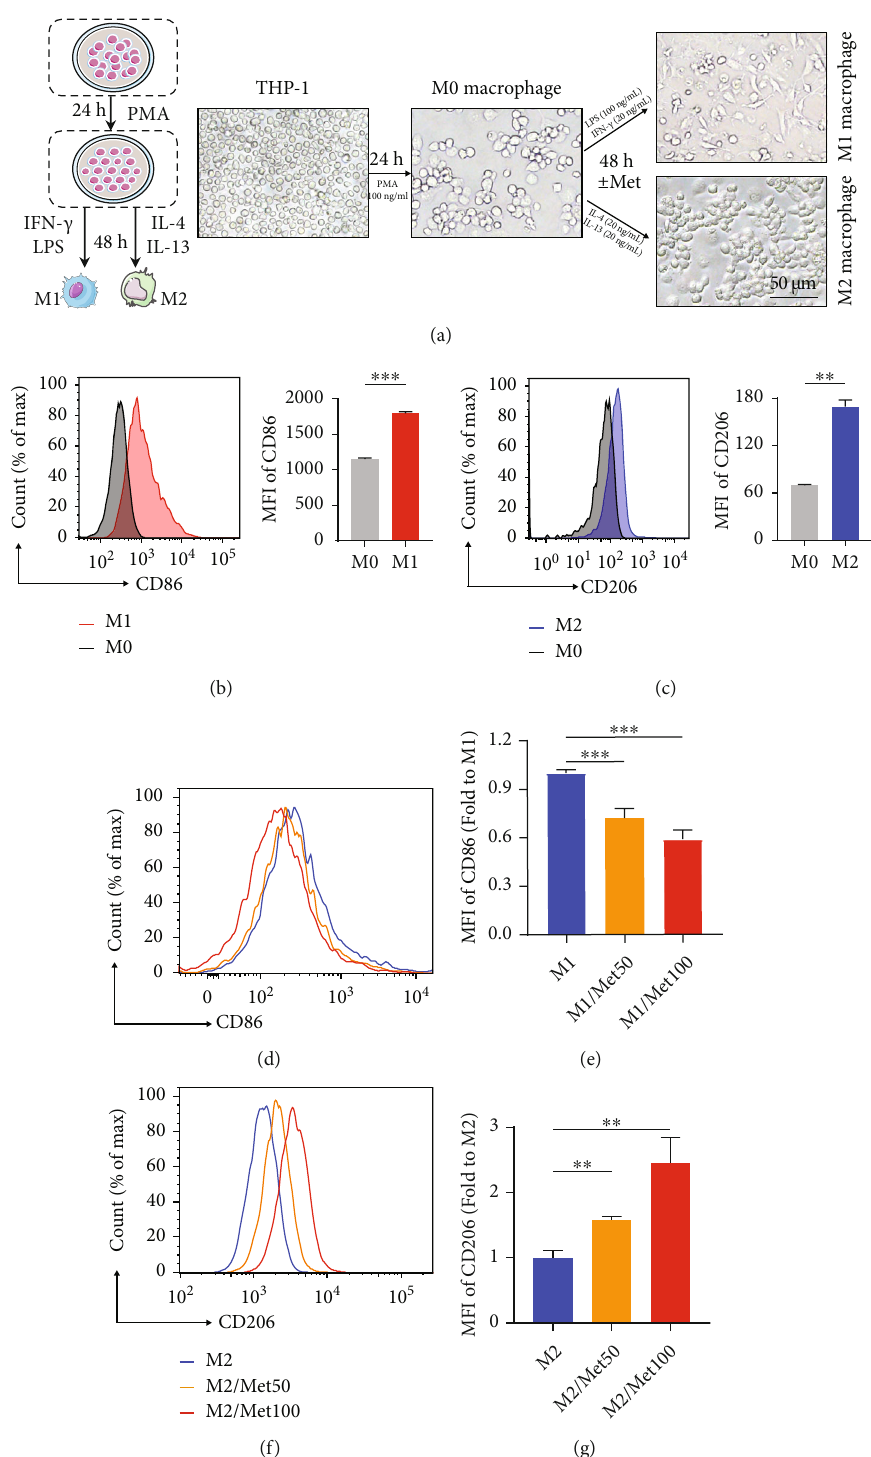
Figure 4: Metformin regulated macrophage polarization towards M2 phenotype. (a) Schematic diagram of polarization of macrophages from THP-1 to M1/M2 populations. (b, c) Representative graphs and statistical histograms of MFI of CD86 maker in M1-induced group and CD206 in M2-induced group versus M0 populations. (d) Flow cytometry plot of CD86 (M1 maker) with di ff erent doses of metformin. (e) Quantitative analysis of the MFI of CD86. (f) Representative image of CD206 (M2 maker) with di ff erent doses of metformin. (g) Quantitative analysis of the MFIofCD206.Datarepresentedas mean ± SD fromthreeindependentexperiments. ∗∗ P < 0 : 01 , ∗∗∗ P < 0 : 001